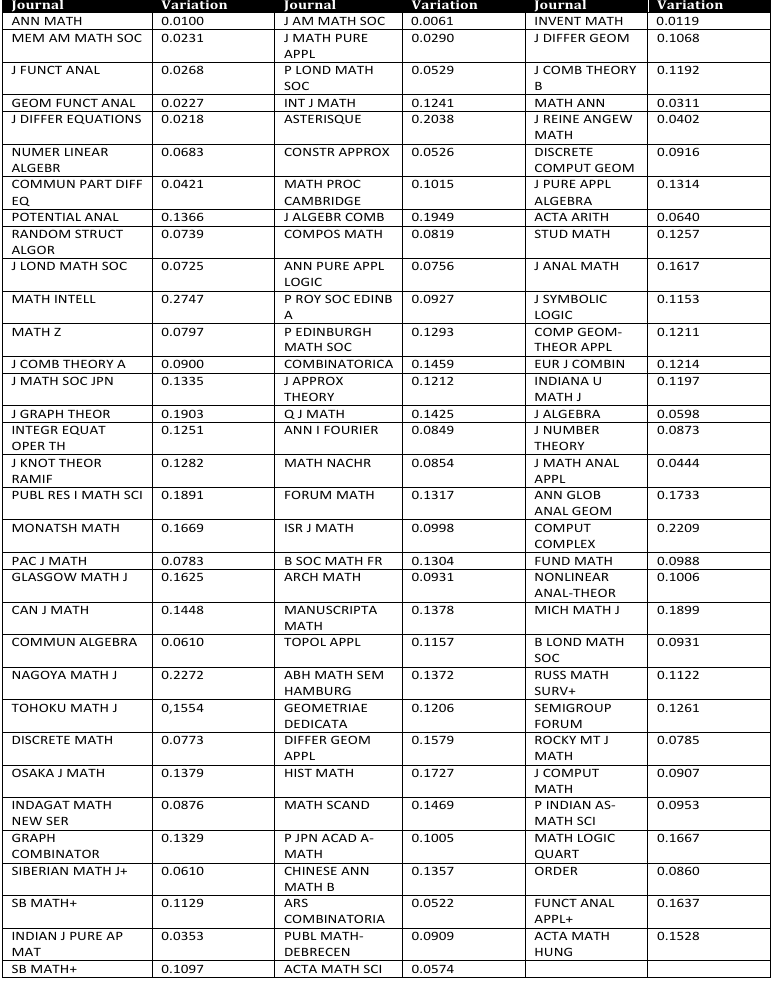
Figure 2. Mean variations of the journals in the list of